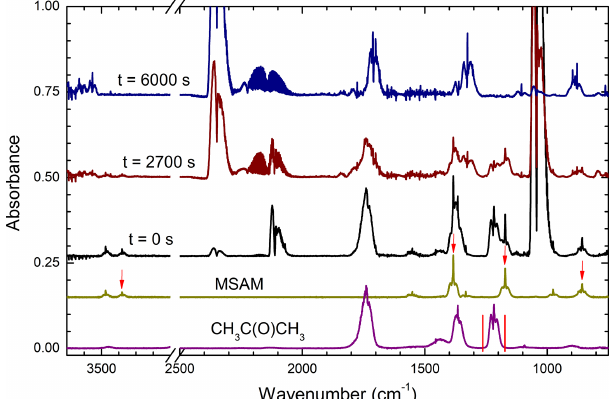
Figure 2. Raw data from a relative rate experiment (using acetone as reference reactant) showing the gradual depletion of reactants and formation of products. The lower two spectra are reference spectra, indicating (red arrows and red min–max lines) which absorption features were used for the relative rate analysis. The strong absorp- tion close to 2100cm − 1 at t = 0s is due to O 3 . CO 2 and CO ab- sorption bands are centred at ≈ 2350 and 2140cm − 1 ,